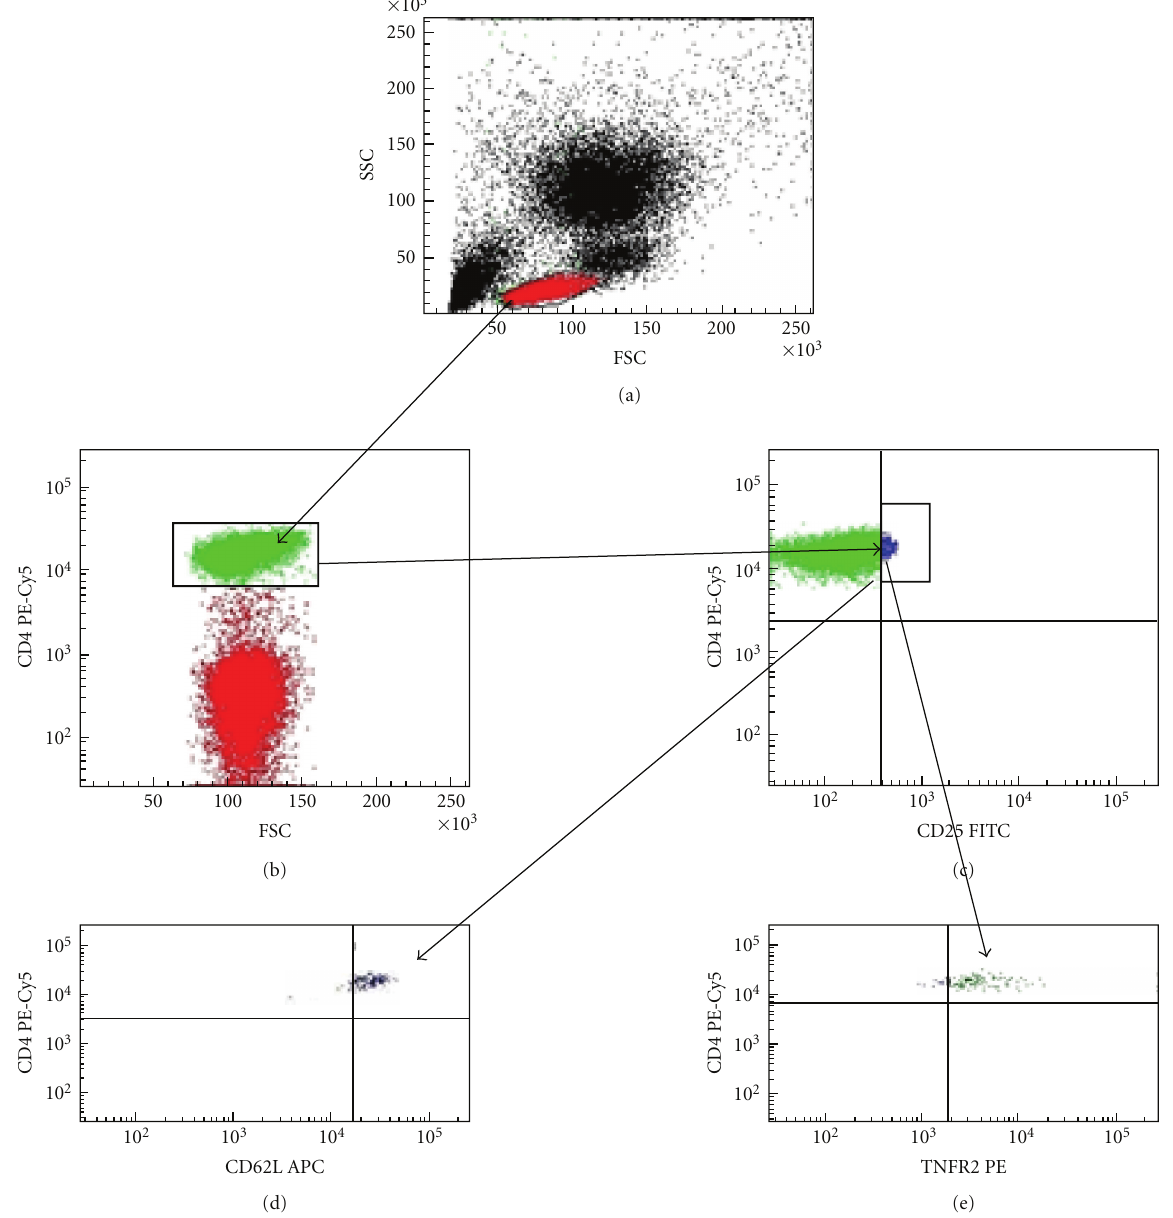
Figure 1: Gating strategy used to analyze CD4 + CD25 high regulatory T cells in peripheral blood. The whole blood was stained with antibodies against Treg cell surface molecules. Sample gated on lymphocytes according to forward and side scatter (FSC/SSC) (a). Plots showing gate for CD4 + T cells (b) and CD4 + CD25 high cells (c). Cells in CD4 + CD25 high gate gated on TNFR2 + (d) and CD62L high cells